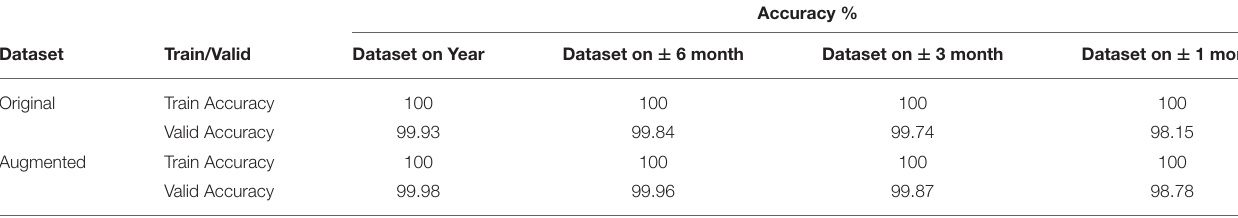
TABLE 3 | Experimental result on a dental dataset based on HCNN-KNN.